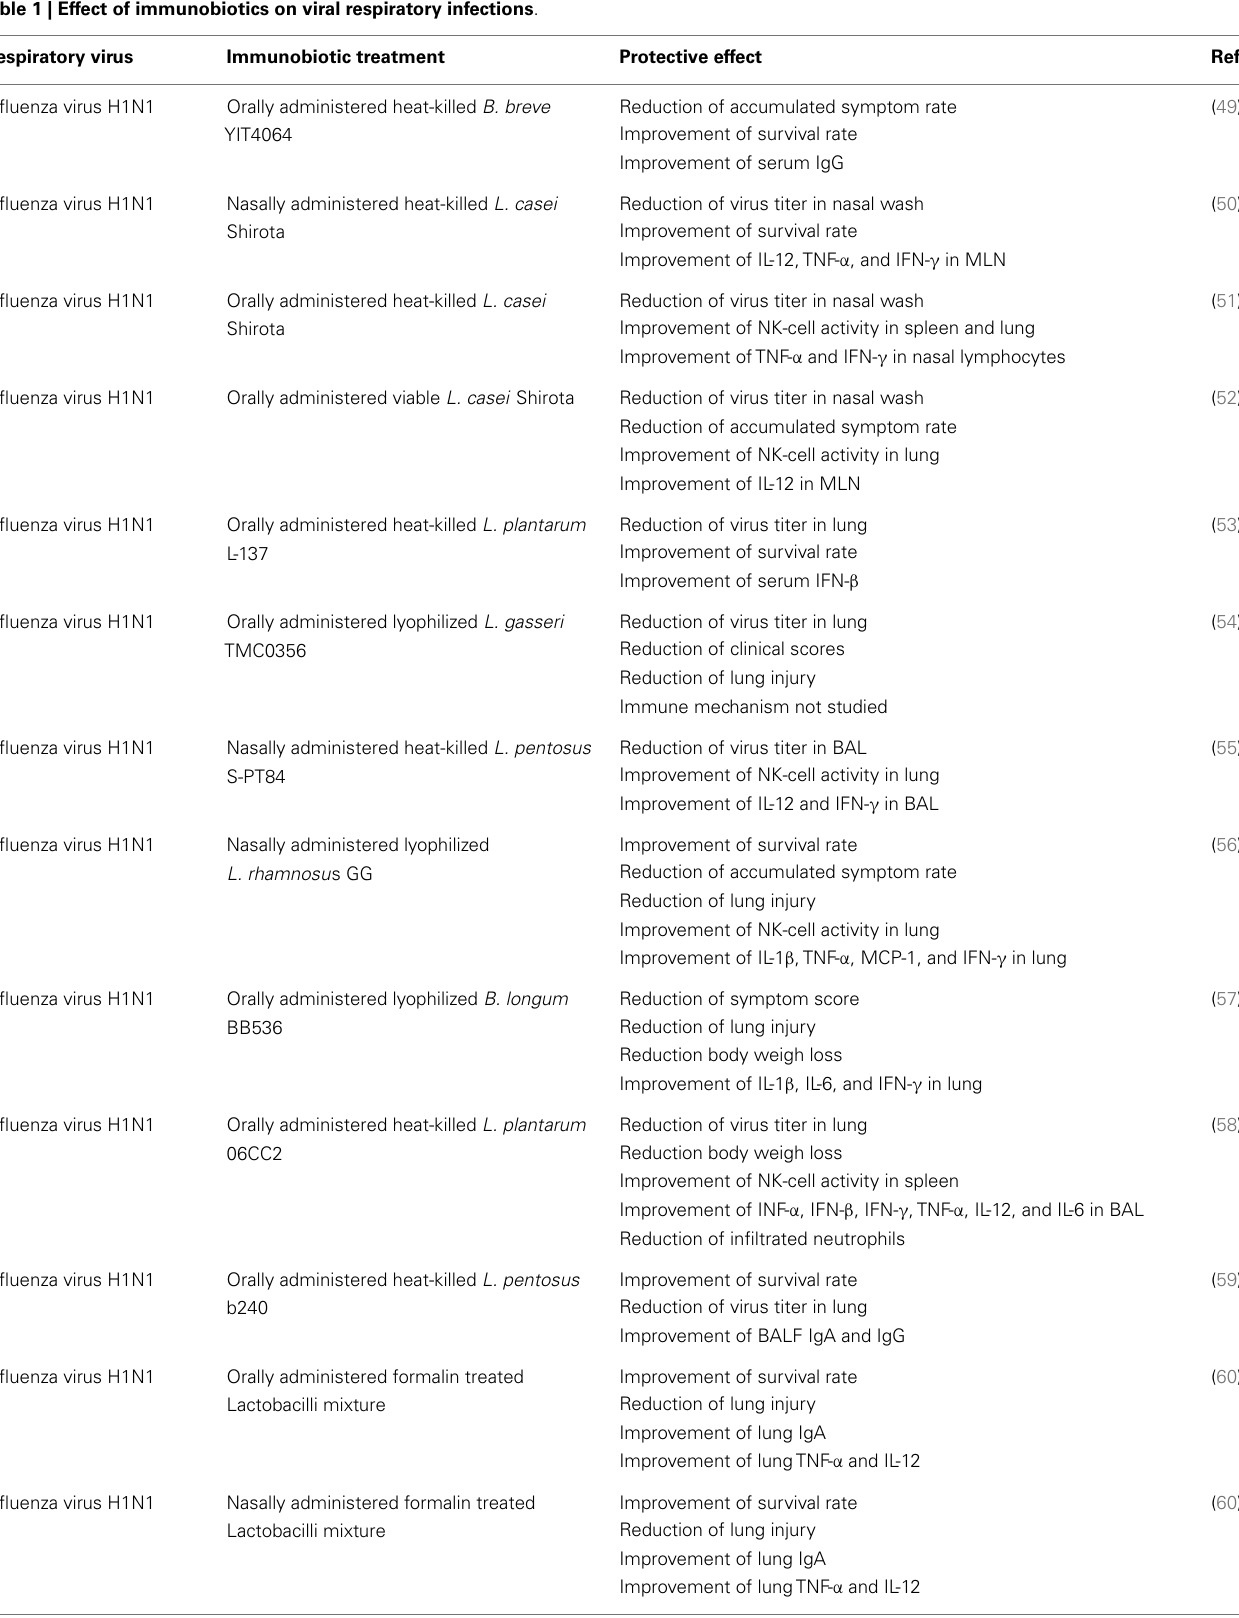
Table 1 | Effect of immunobiotics on viral respiratory infections